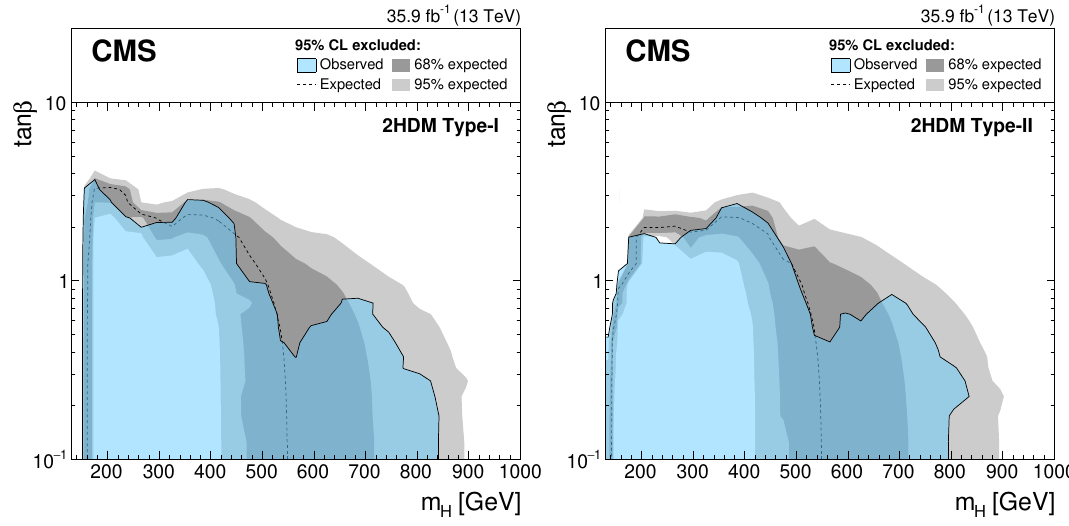
Figure 7 . Expected and observed 95% CL upper limits on tan (cid:12) as a function of m (left) and Type-II (right) 2HDMs. It is assumed that m The expected limit is shown as a dashed black line while the dark and light gray bands indicate the 68 and 95% CL uncertainties, respectively. The observed exclusion contour is indicated by the blue